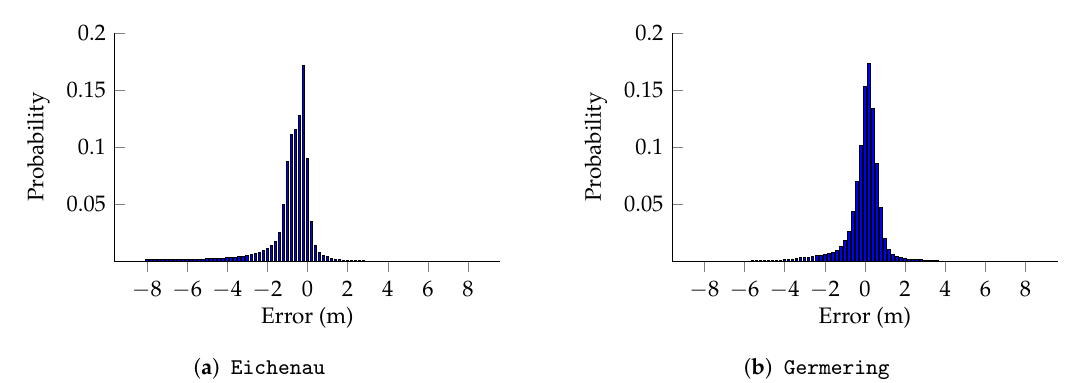
Figure 17. Histograms of the height differences between the aligned DSMs generated from UAV and aerial images for the ( a ) Eichenau and ( b ) Germing datasets.